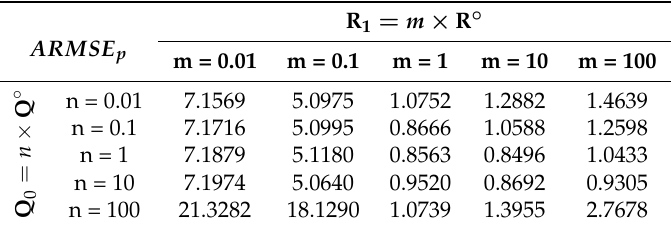
Table 1. ARMSE p results of SUKF.